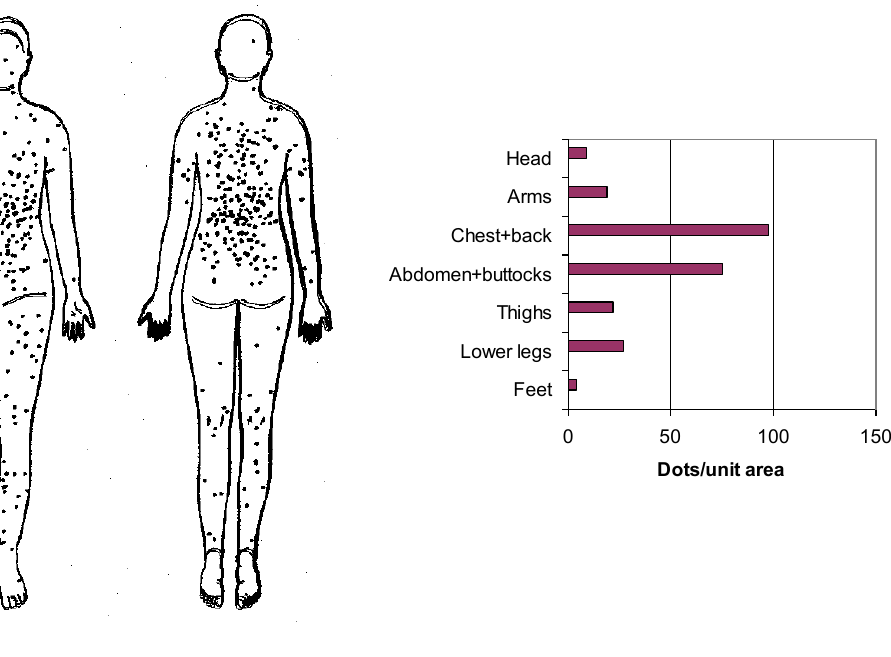
Figure 6. Distribution of melanoma over the body and the relative rate of melanoma per unit body area. Data are from Sweden and the details are from two doctoral thesis publications further referred to in [4].